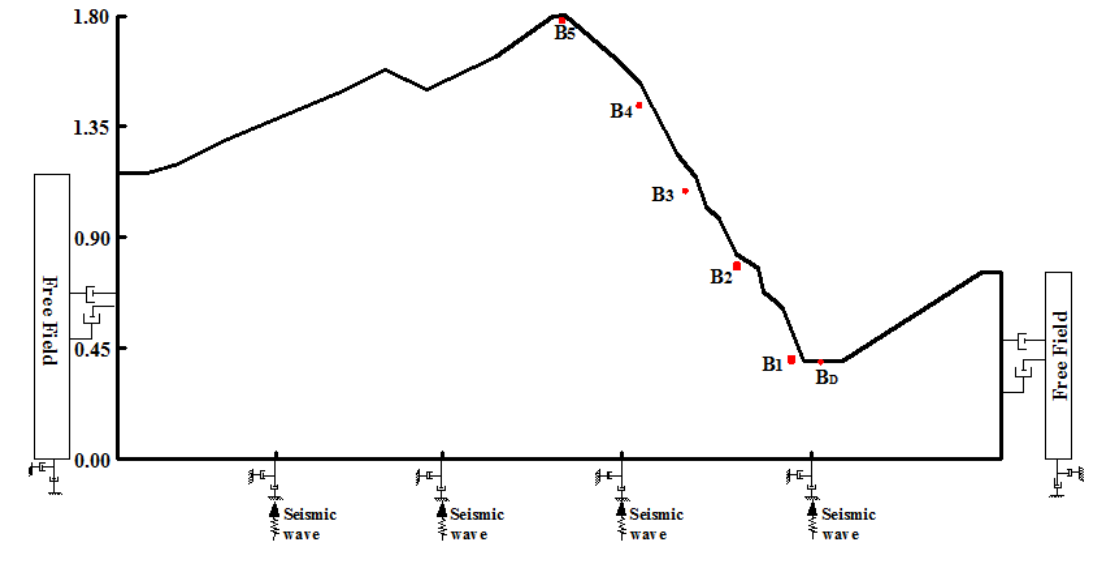
Figure 10. Distribution of monitoring points of the one-sided slope.